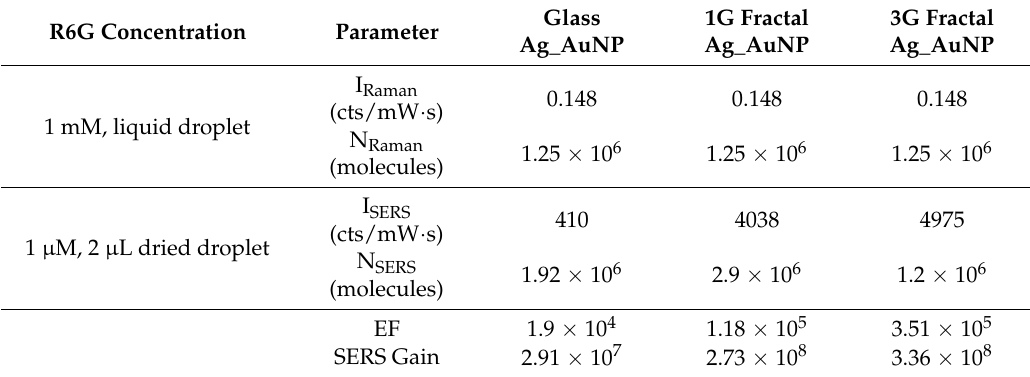
Table 2. Enhancement factor and SERS gain for the 2D and 3D SERS substrates studied in this work. Glass R6G Concentration Parameter R6G Concentration